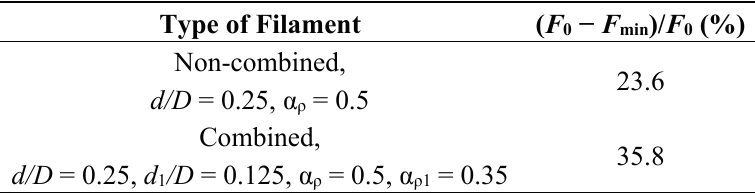
Table 4. Hemisphere-cylinder, M = 3.45.